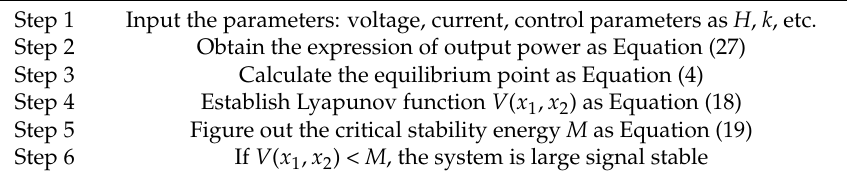
Table 1. Rules and steps of the stability domain determination.